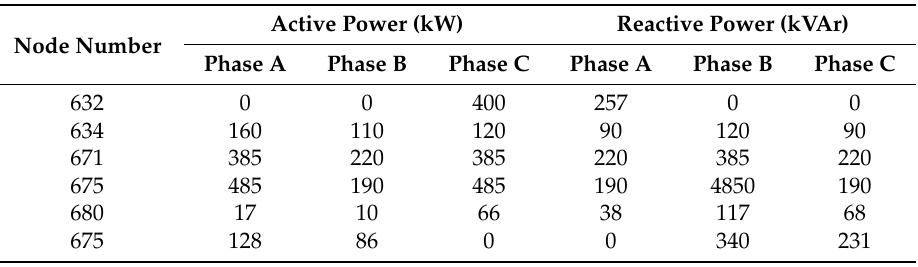
Table 2. Loads Active and Reactive Power for heavy loading condition.